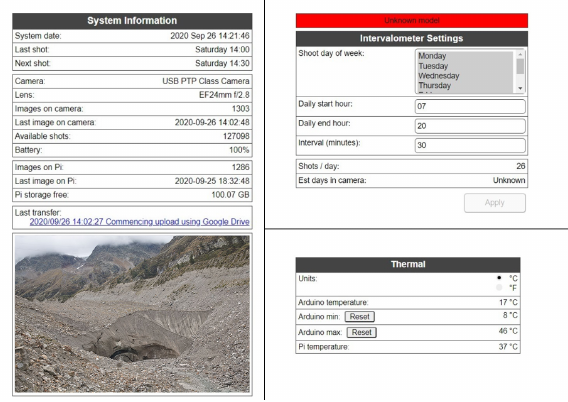
Figure 3. Example of some of the pages of the web-based interface to remotely control the monitoring